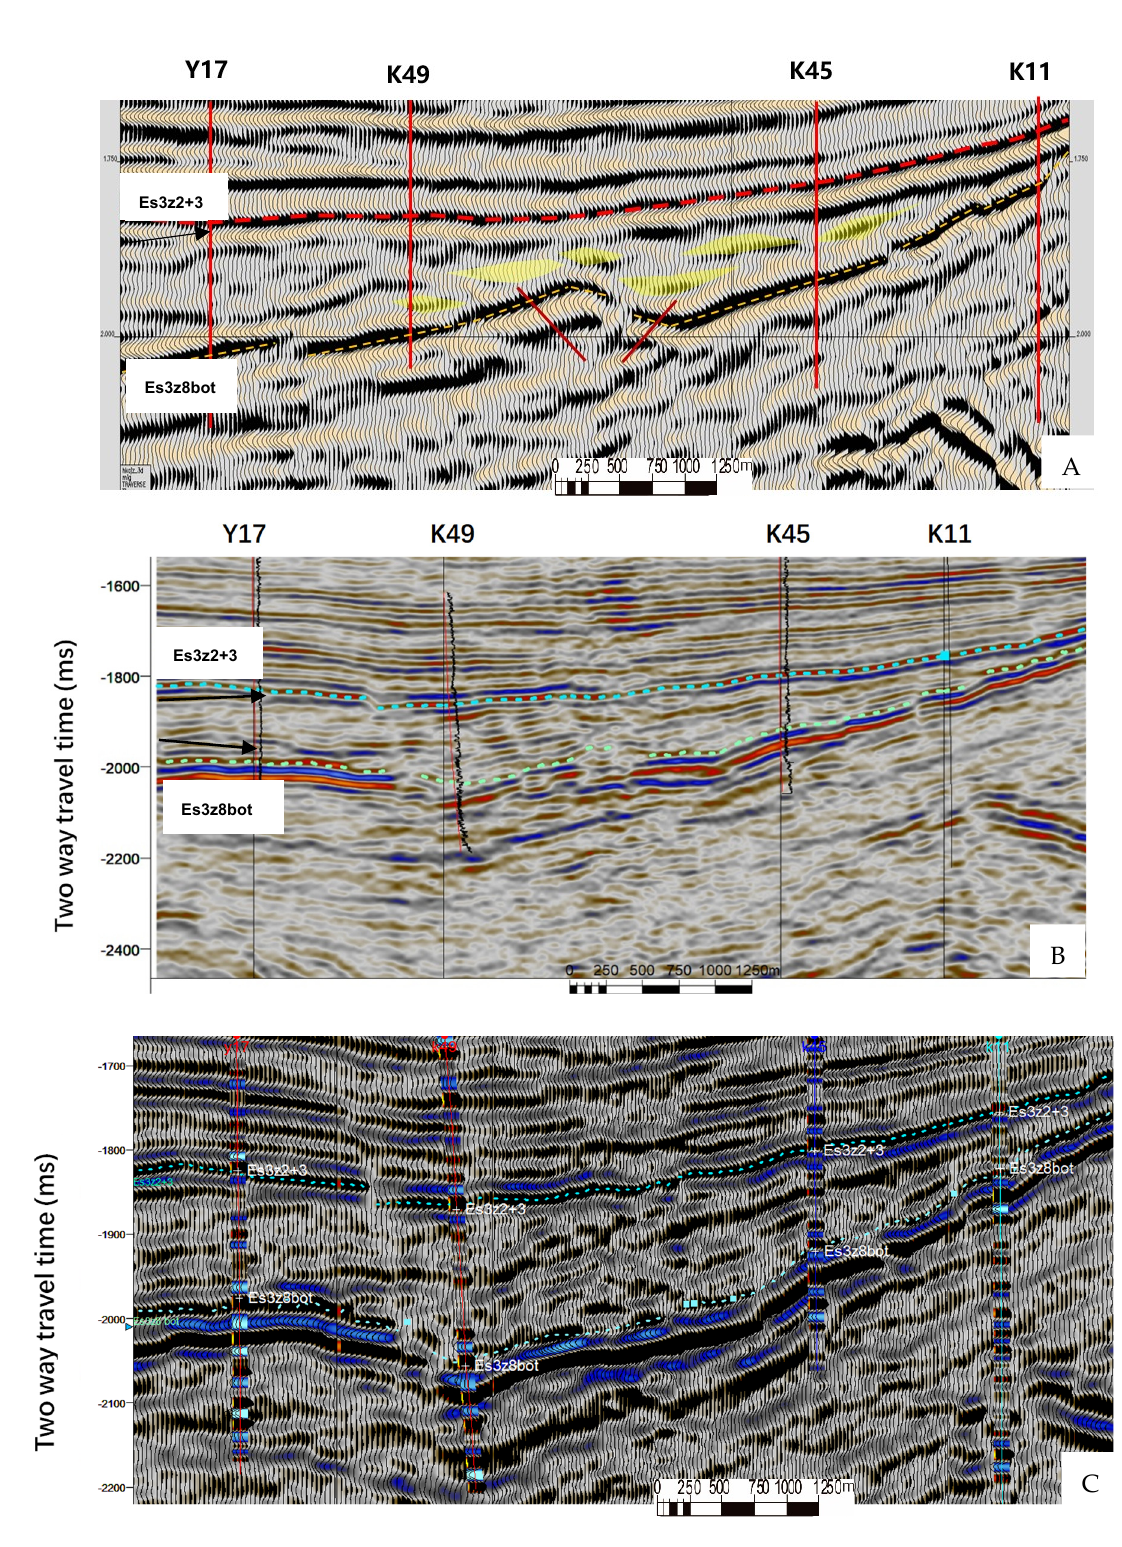
Figure 11. ( A ) Eye shape reflections, marked as fan delta front deposit from east to west profile (seismic profile 5 of location area in Figure 10). ( B ) Calibration of seismic with GR logs in key wells ( C ) Synthetic seismogram generation in key wells (Profile 5 shown in Figures 1 and